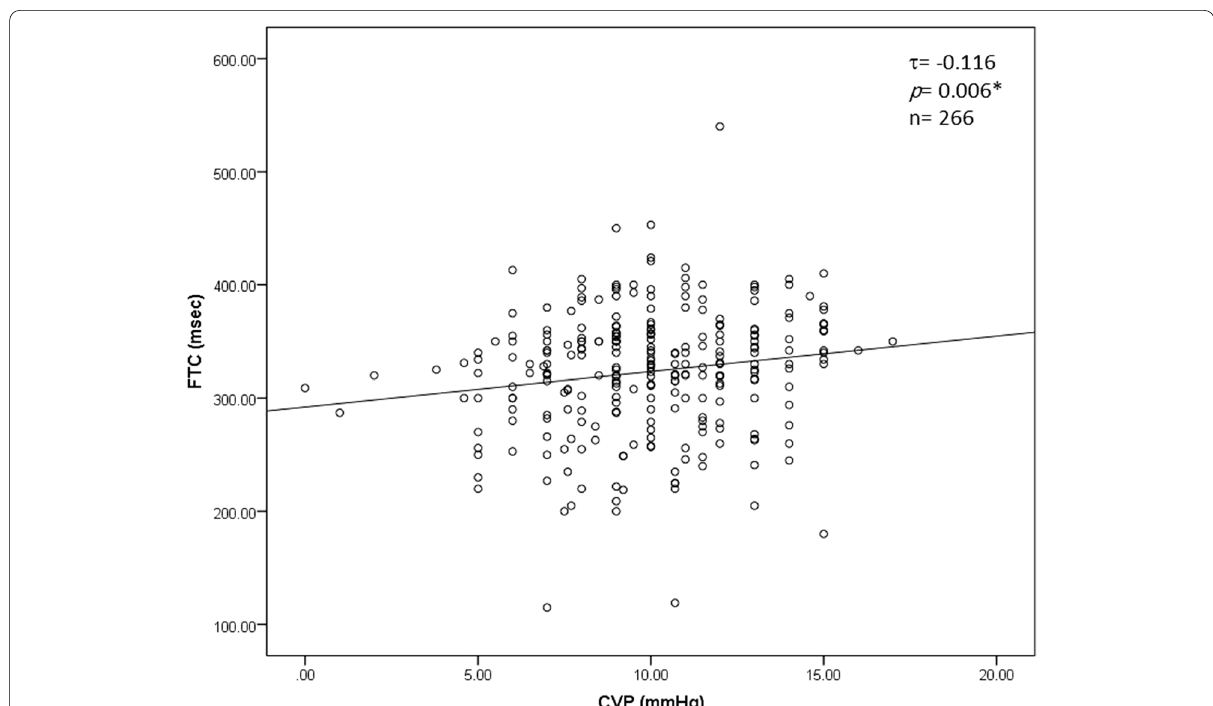
Fig. 3 Simple scatter plot with regression (best fit) line and correlation between transesophageal Doppler corrected flow time (FTc, msec) and central venous pressure (CVP, mmHg)